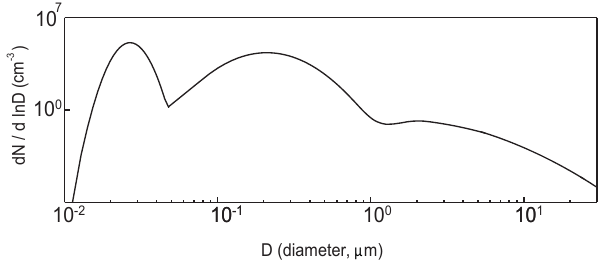
Figure 3. Aerosol size distribution at the surface. N represents aerosol number concentration per unit volume of air and D rep- resents aerosol